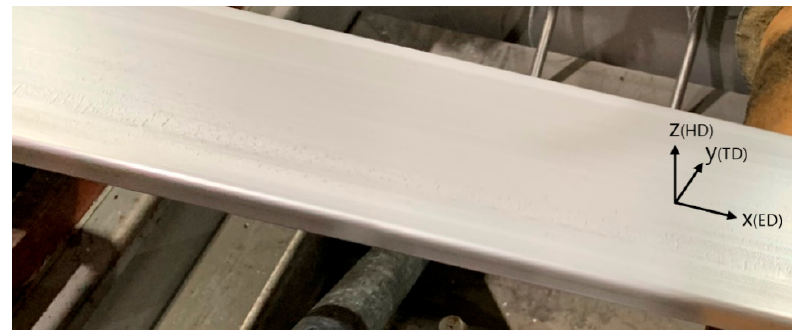
Figure 1. Extruded 7075 aluminum alloy thick plate.